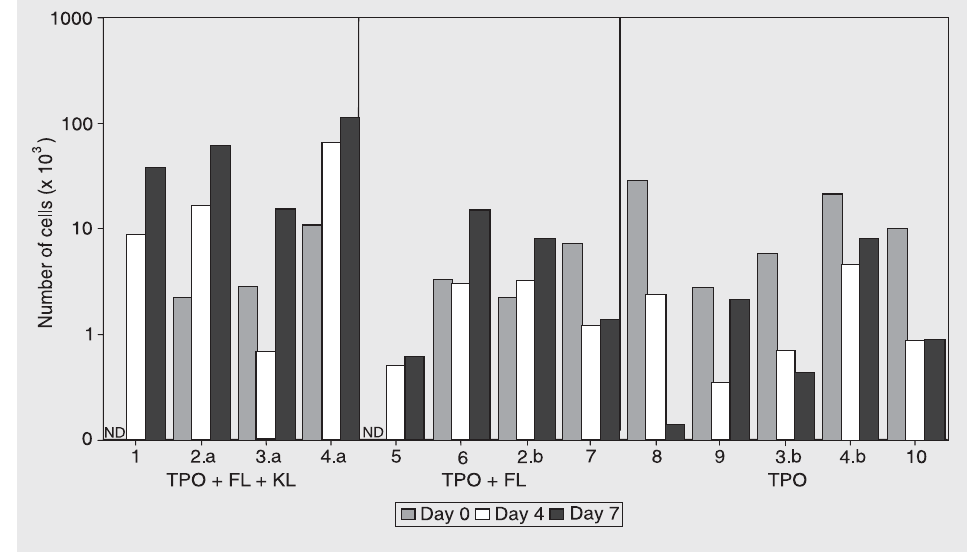
Figure 2. Number of viable CD38 - cells among viable CD34 + cells in culture. Note the logarithmic scale on the ordi- nate. ND = not determined; TPO = thrombopoietin; FL = FLT-3 ligand; KL = kit